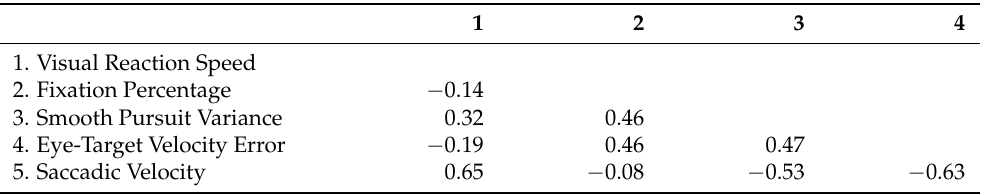
Table 1. Strengths of the associations between the various eye-tracking